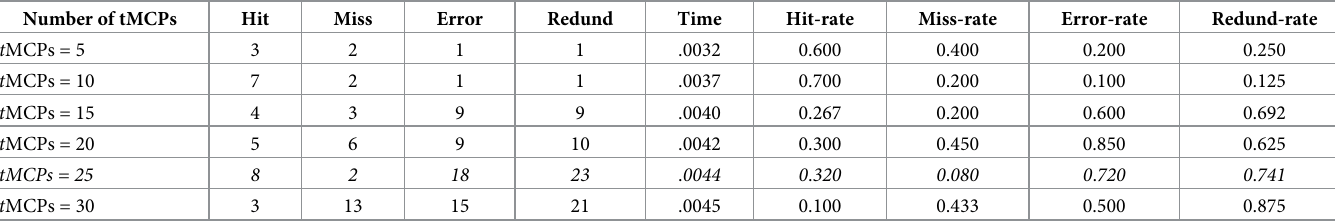
Table 4. The results of MCPs detection as the t MCPs ranged from 5 to 30 in the WBS&CUSUM method. Number of